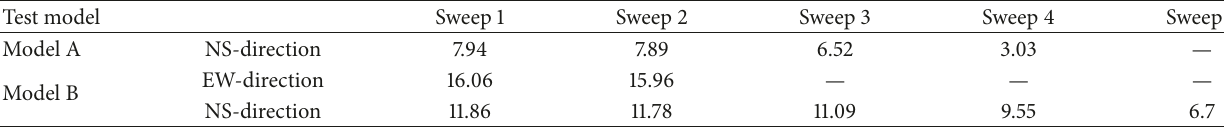
Table 3: Fundamental frequencies of USMS model and SMS model